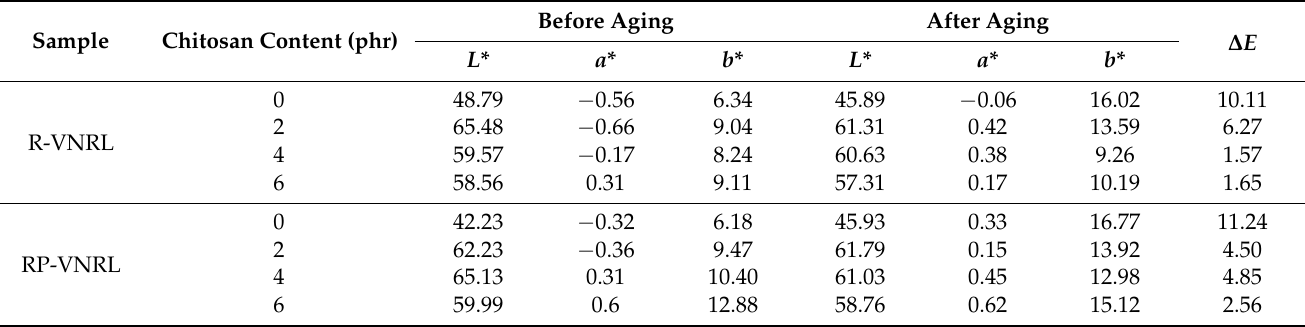
Table 4. Color indices of non-aged and thermal-aged CS/R-VNRL and CS/RP-VNRL composites with varying CS contents of 0, 2, 4, or 6